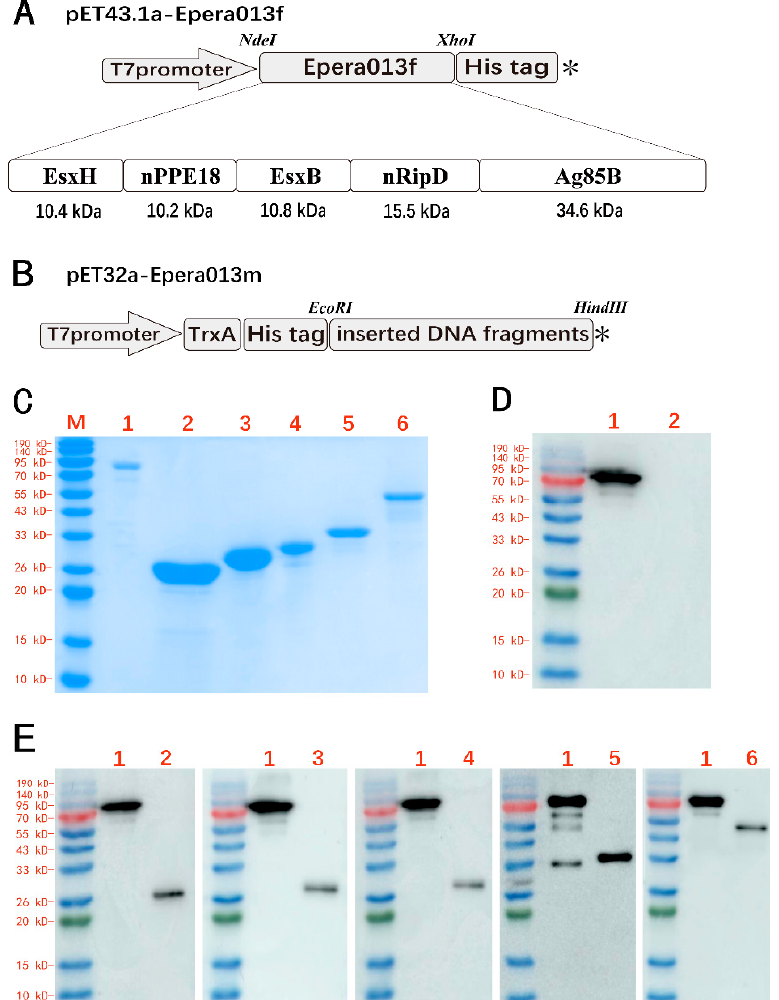
Figure 3. Epera013f recombinant protein construction and characterization. ( A ) The structural diagram of the recombinant prokaryotic expression plasmid pET43.1a-Epera013f. ( B ) The structural diagram of the recombinant plasmid constituted Epera013m. ( C ) SDS-PAGE analysis of purified Epera013f protein and five single individual proteins of Epera013m. Lane M, protein molecular weight marker; lane 1, Epera013f; lane 2, EsxH; lane 3, nPPE18; lane 4, EsxB; lane 5, nRipD; lane 6,